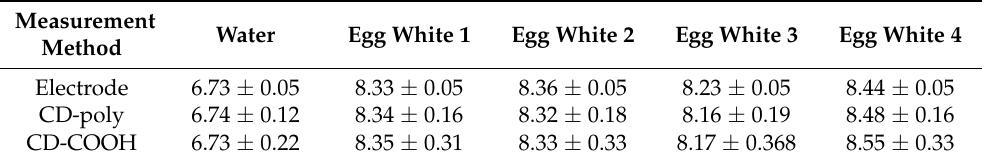
Figure 9. UCL of CDs in chicken egg white (lower half of the image) upon excitation at a wavelength of 720 nm. Table 1. The pH values of the water and chicken egg white obtained using a pH electrode and from the spectra of CDs’ UCL.